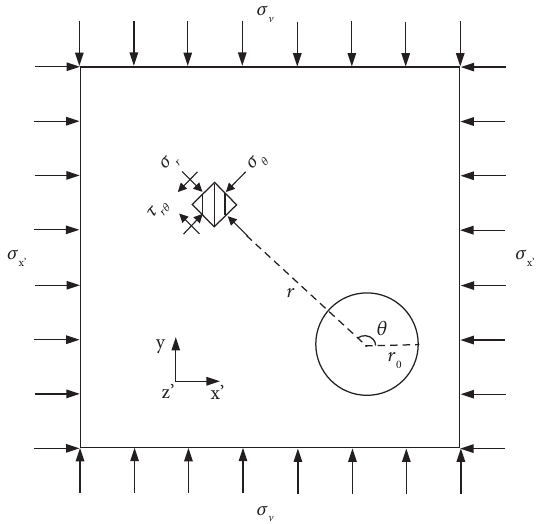
Figure 11: The x ′ - y section view of stress state ( φ � 0 ° ).